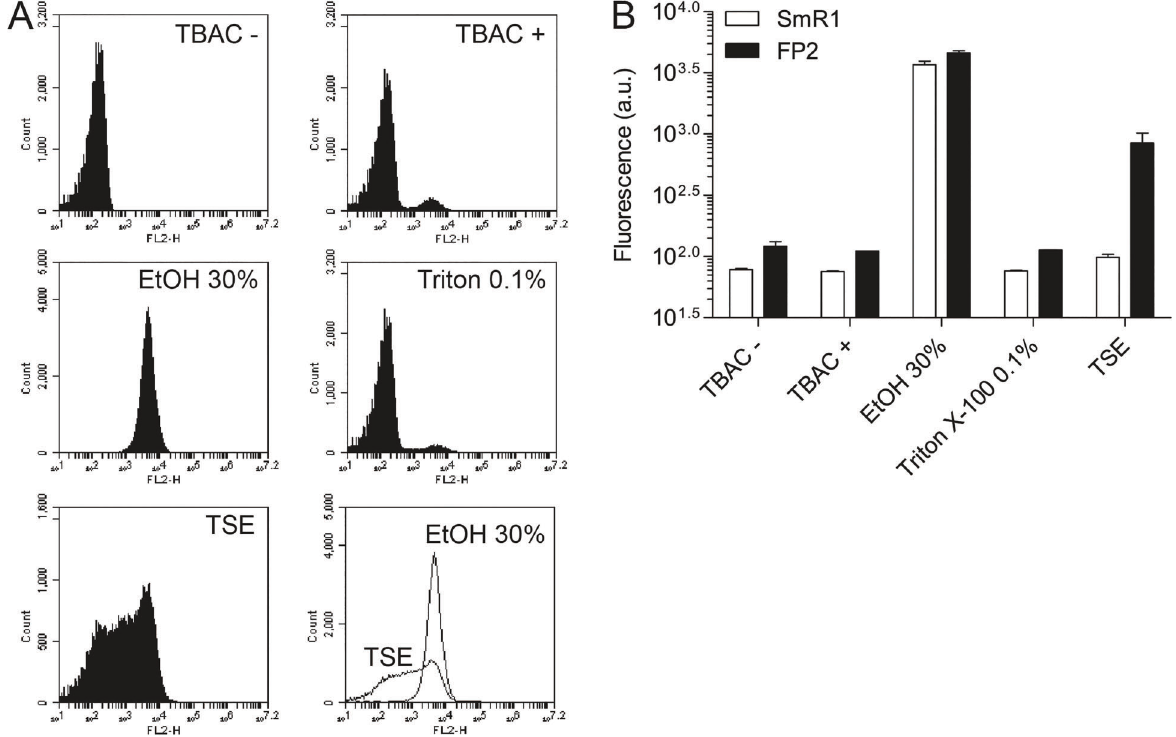
Figure 1. Screening for cell permeabilization solutions. Bacteria were grown at an OD 600 of 1.2, 0.1 mL was centrifuged (1 min at 13,400 g ), and resuspended in 1 mL of each solution evaluated. The bacterial suspensions were stained with NR (9.42 m M) during 5 min, and analyzed by fl ow cytometry. A , Histograms are representative of A. brasilense strain FP2. Conditions: TBAC – corresponds to Nile red (NR) non-stained samples, used as a blank. All other samples were stained with NR. TBAC + corresponds to non-permeabilized samples in TBAC. EtOH 30% corresponds to samples in TBAC containing 30% of ethanol. Triton 0.1% corresponds to samples in TBAC containing 0.1% of Triton X-100. TSE corresponds to samples in TSE buffer. TSE/EtOH 30% corresponds to overlay of two histograms, TSE and EtOH 30%, respectively. B , Fluorescence data (arbitrary units, a.u.) are reported as means ± SD of 3 independent experiments with H. seropedicae strain SmR1 and A. brasilense strain FP2, by using the median fl uorescence intensity values in the FL2-H